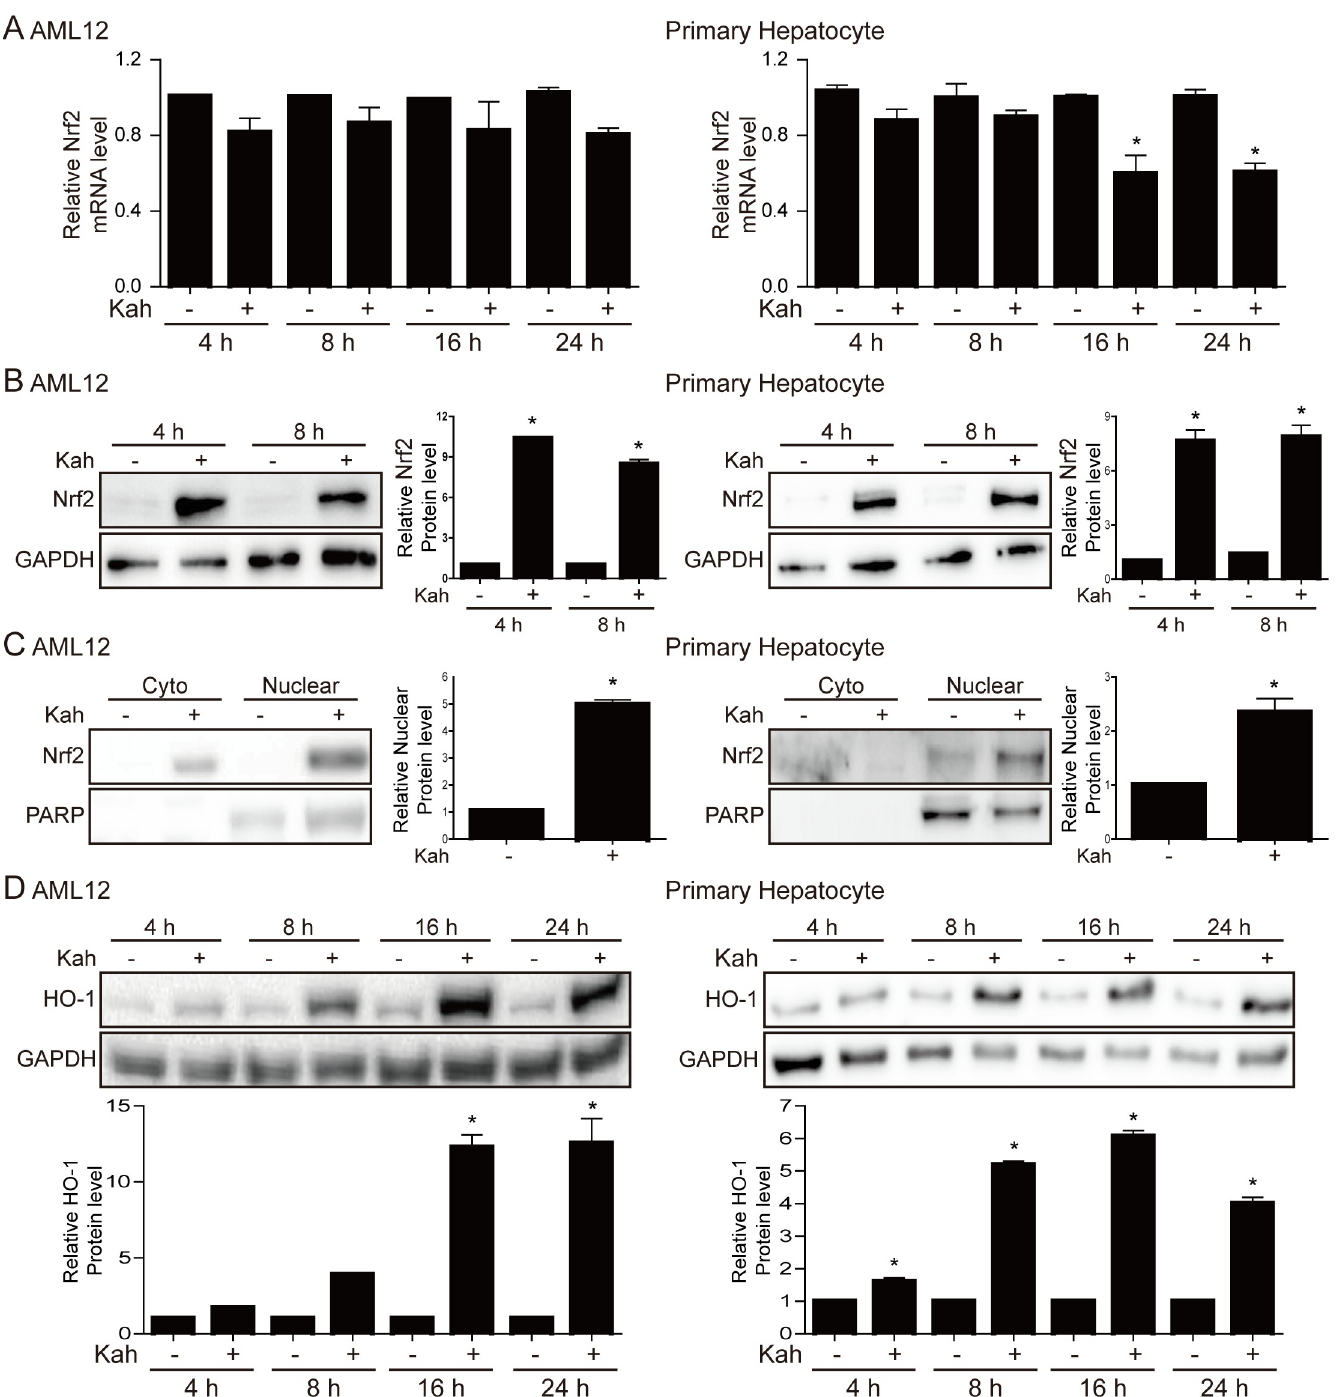
Fig 2. The effects of kahweol (Kah) on Nrf2 and HO-1 expression. AML12 cells were treated with 20 μ M kahweol and primary hepatocytes were treated with 40 μ M kahweol. ( A ) Representative real-time RT-PCR analyses of Nrf2 mRNA expression in AML12 cells (left) and primary hepatocytes (right). � p < 0.05, � p < 0.05 compared with the control for each time. ( B ) Western blot analyses showing the effect of kahweol on Nrf2 expression in whole cell extracts of AML12 cells (left) and primary hepatocytes (right). Data in the bar graph are means ± SEM of three independent measurements. � p < 0.05 compared with the control for each time. ( C ) Western blot analysis of cytoplasmic and nuclear extracts of AML12 cells (left) and primary hepatocytes (right), showing the effects of kahweol on Nrf2 expression. Kahweol was treated for 24 hours. Data in the bar graph are means ± SEM of three independent measurements. � p < 0.05 compared with the control. ( D ) Western blot analyses showing the effect of kahweol on HO-1 expression in AML12 cells (left) and primary hepatocytes (right). Data in the bar graph are means ± SEM of three independent measurements. � p < 0.05 compared with the control for each time.